Question: Describe this figure in one sentence.
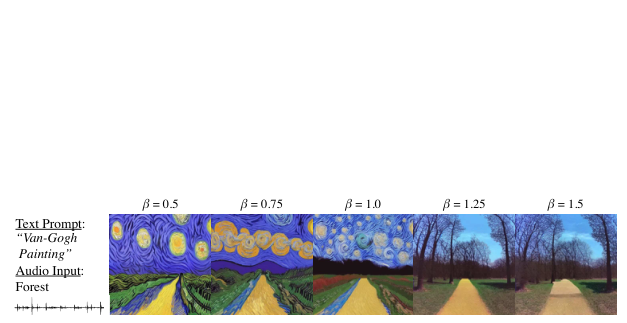
Answer: Influence of the 𝜷coefficient. As shown in this example, setting the value of 𝛽specifies the strength of how the generated process will be modulated in relation to the audio versus text input.